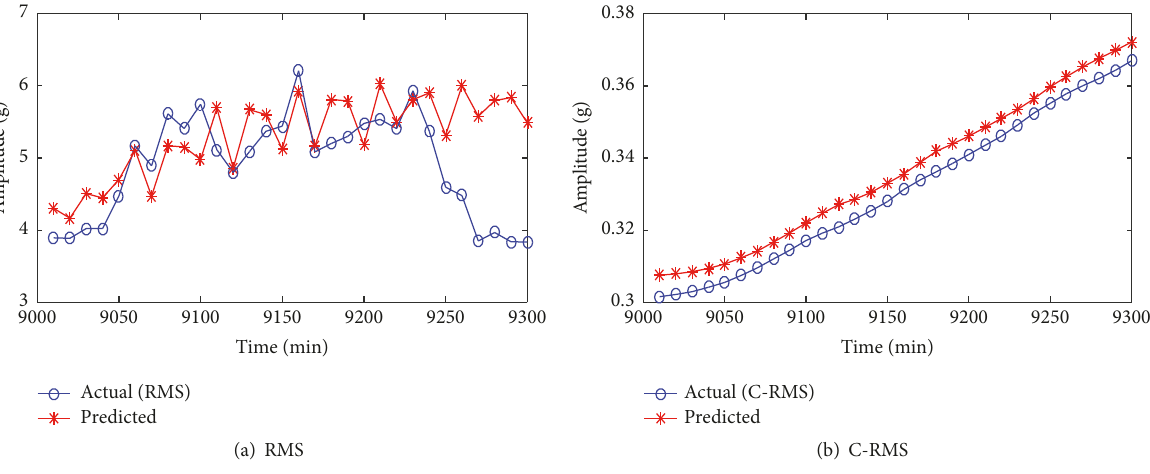
Figure 16: Prediction results of RMS and C-RMS.